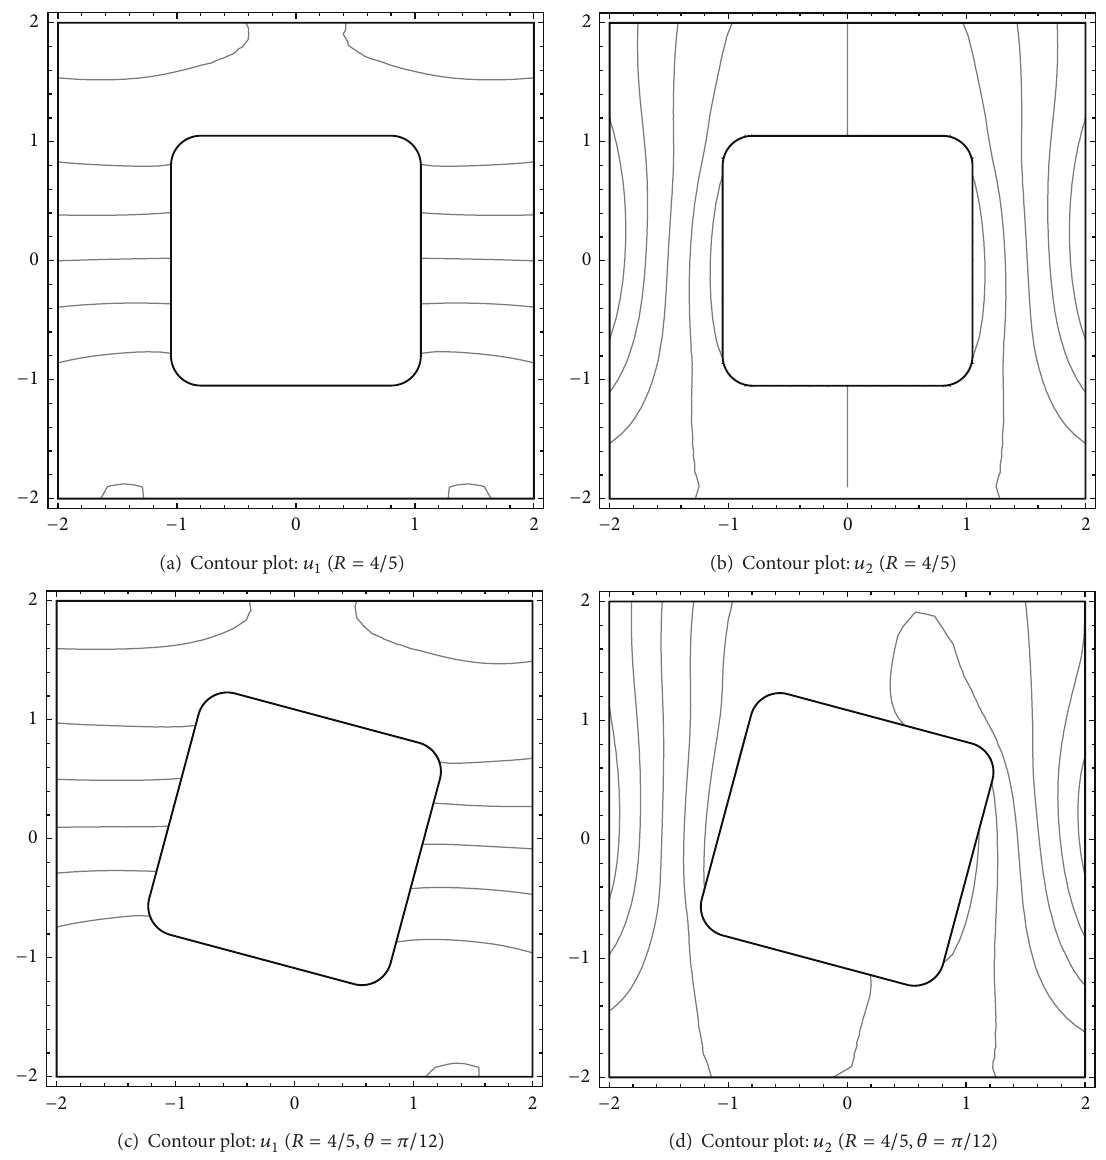
Figure 2: Case A: effect of perturbation on eigenmodes. Contour lines of